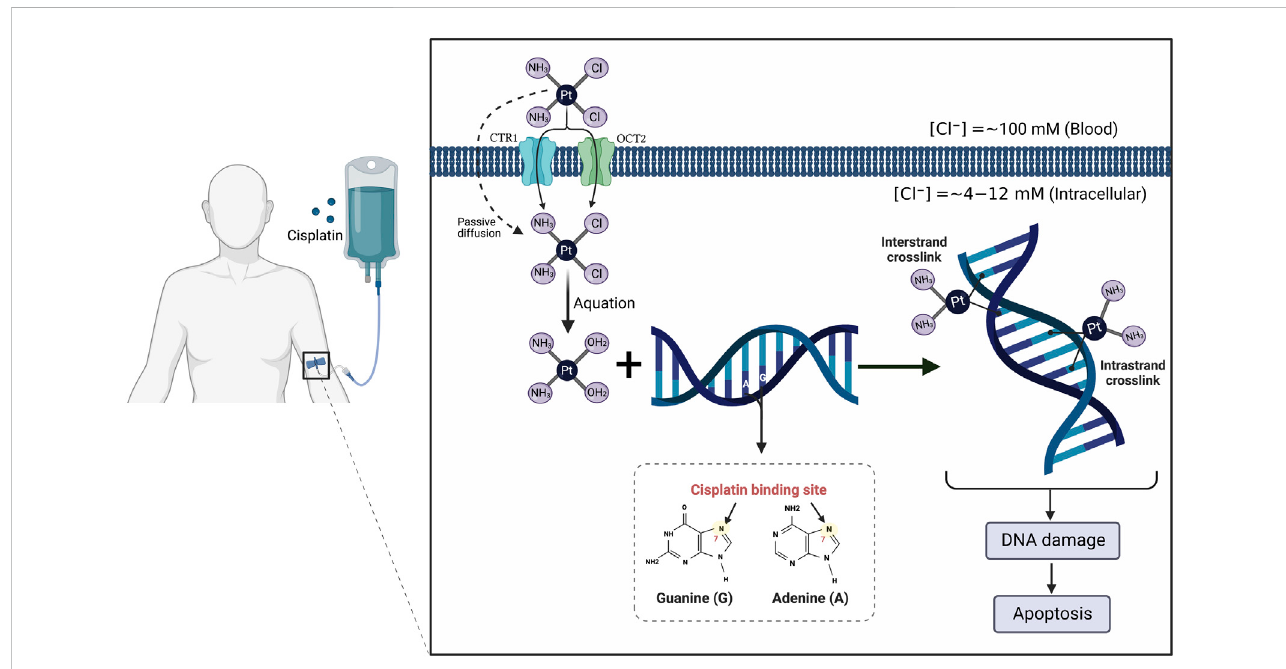
FIGURE 1 Mechanism of action of cisplatin (CP). The CP structure is composed of a platinum atom in the center, surrounded by two chloride atoms and two ammoniaatomsintheciscon fi guration.Followingitsintravenousinfusion,CPispassedthroughthecellmembranebypassivediffusionoractivetransport.In thebloodstream,thehighchlorideconcentration(~100 mM)retainsCPinarelativelystablestructureandpreventsitshydrolysis.Onceitentersthecellwhere the chloride concentration is greatly reduced (~4 – 12 mM), the two chlorides are replaced by water molecules in a process termed aquation to produce potent,positivelychargedelectrophilicproduct.TheresultingproductcovalentlybindstotheN7atomofthepurinebases,preferentiallyguanines,intheDNA causingformationofeitherintrastrandcross-linking whenthetwoorganicbasesarelocatedonthesameDNAstrandorinterstrandcross-linking isproduced if the organic bases are on opposite strands. These cross-links distort the DNA structure and subsequently lead to cell cycle arrest and